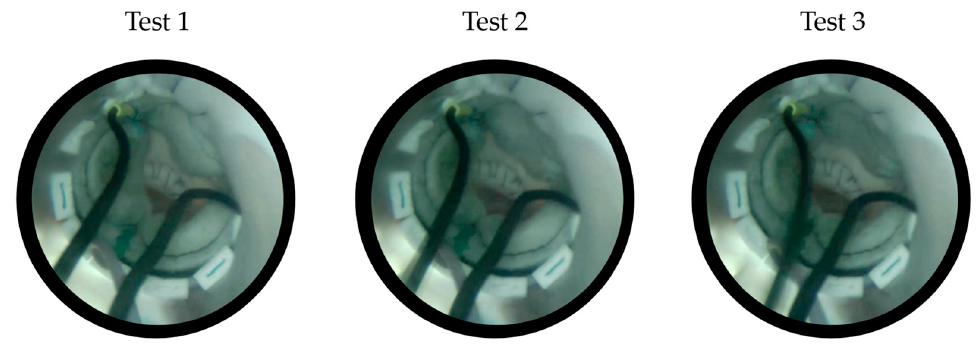
Figure 13. Increased opening area of the valve leaflets when passing from Test 1, Test 2, Test 3, as detected from the endoscopic images. detected from the endoscopic